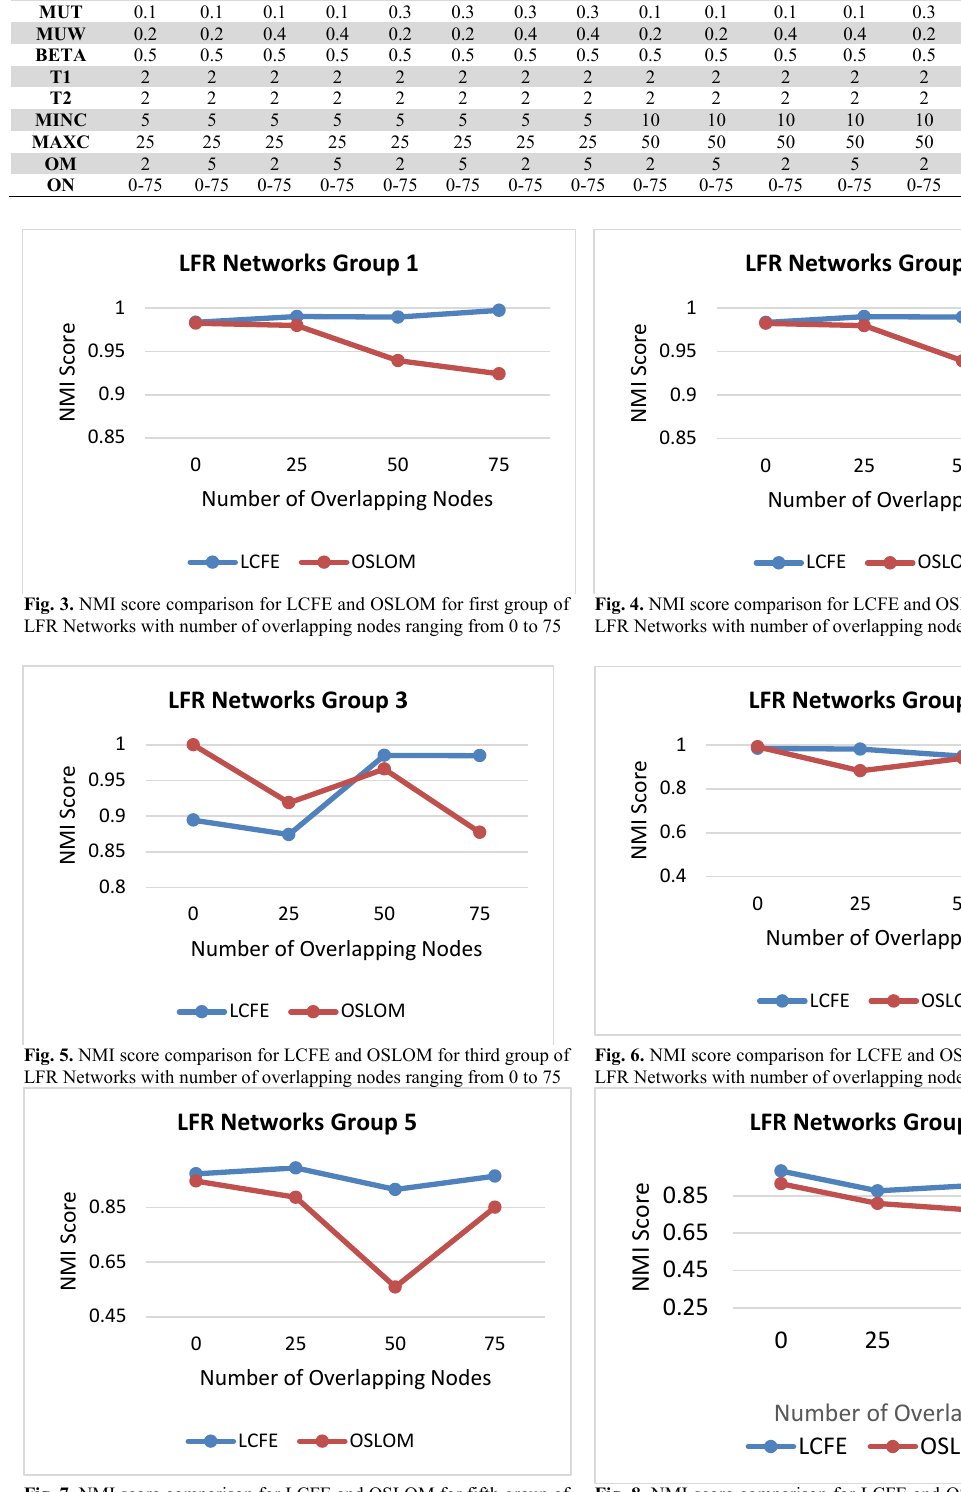
Fig. 8. NMI score comparison for LCFE and OSLOM for sixth group of LFR Networks with number of overlapping nodes ranging from 0 to